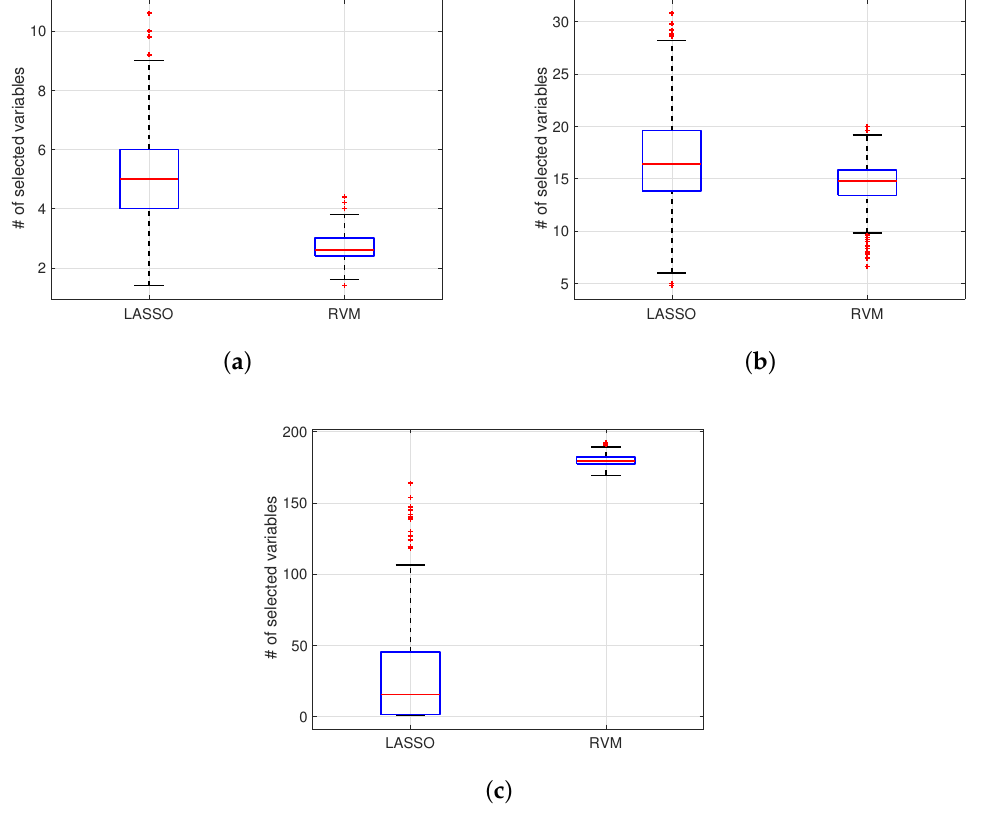
Figure 9. Examples of number of selected variables for RVM and LASSO depending on MCCV iterations (1000). Semiconductor data in ( a ), Arcene ( b ) and Madelon ( c ). For real data case the same set of implementation details was kept, i.e., in terms of number of Cross-Validation, percentage of training and test data, etc. (as explained in Section